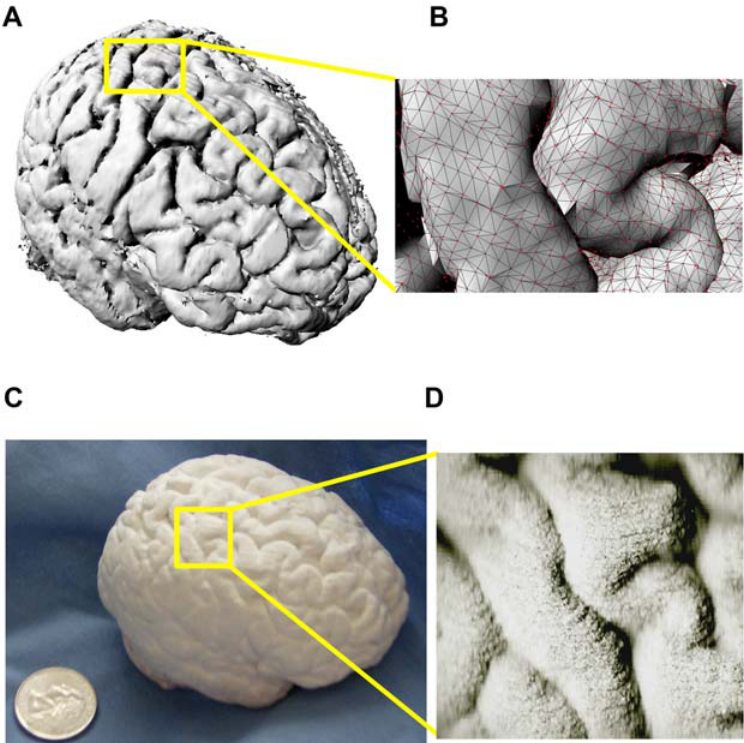
Figure 2. VR and Rapidly Prototyped Stereolithographic Human Brain Model. The processing pathway we developed can replicate living specimens. (a) Cortical isosurface of virtual whole human brain. (b) Right hemisphere cortical isosurface of pre- and postcentral (left) gyrus with wireframe mesh (black) and vertices (red). (c) Physical whole human brain stereolithograph replica. (d) Right hemisphere pre- and postcentral (left) gyrus for comparison with Figure 2b.